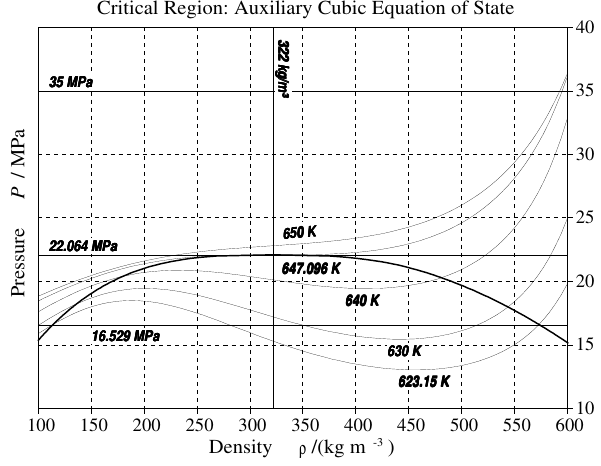
Fig. A3: Selected isotherms of the auxiliary cubic equation of state, Eq. (A4), in the critical Fig. A3. Selected isotherms of the auxiliary cubic equation region 623.15 < T < 650 K, 16.529 < P < 35 MPa. Shown in bold is the saturation-pressure of state, Eq. (A4), in the critical region 623.15 <T < 650K, curve of IAPWS-95, separating the single-phase region above from the two-phase region below. The critical point is at T C = 647.096 K, ρ C = 322 kg m –3 , P C = 22.064 MPa. Given a 16.529 <P< 35MPa. Shown in bold is the saturation-pressure curve line of constant subcritical pressure P and an isotherm T , their intersection points with of IAPWS-95, separating the single-phase region above from the positive slopes provide either the density estimate for ρ V ( T , P ) of vapour (on the left branch) or for ρ W ( T , P ) of the liquid (on the right), separated from each other by the unstable region of two-phase region below. The critical point is at T C =647.096K, negative slopes. ρ C =322kgm − 3 , P C =22.064MPa. Given a line of constant sub- critical pressure P and an isotherm T , their intersection points with The initial densities for the iteration, Eq. (A3), in the critical region are computed from the positive slopes provide either the density estimate for ρ V (T, P) of intersection points of the horizontal isobars with the isotherms as shown in Fig. A3. In the vapour (on the left branch) or for ρ V (T, P) of the liquid (on the subcritical range, T < T C and P < P C , there exist three solutions, the vapour density to the left of the isotherm maximum, the liquid density to the right of the minimum, and an extraneous right), separated from each other by the unstable region of negative unstable solution in between the extrema. The curve (not shown) connecting the minima and slopes. the maxima of adjacent isotherms, which passes smoothly through the critical point, is the spinodal of the auxiliary equation. Beneath the spinodal, the compressibility is negative, ( ) 0/ <∂∂ T P ρ , thermodynamic stability is violated and no stable single-phase states can exist. By means of this stability gap, the spinodal separates low-density vapour from high-density liquid on the particular isotherm. At the critical point, maximum, minimum and inflection point coincide, and at supercritical temperatures only one fluid solution exists for any given